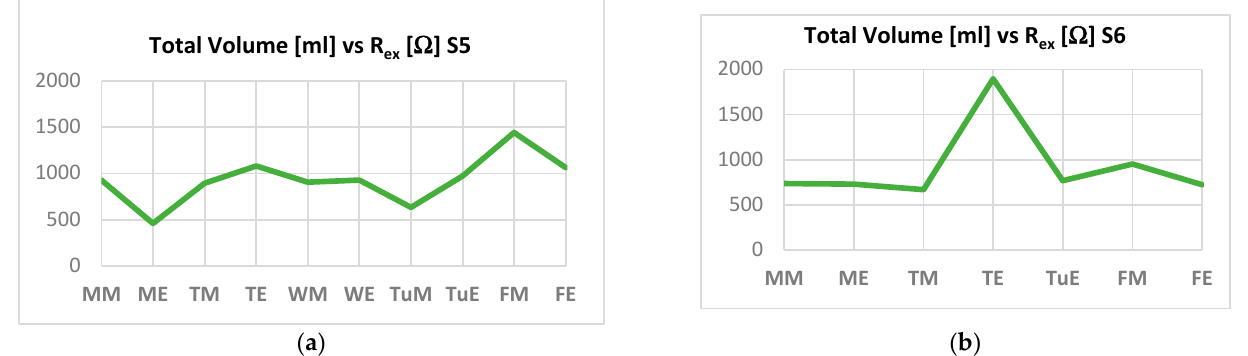
Figure 10. Volume estimated for all subjects versus test point (unhealthy).